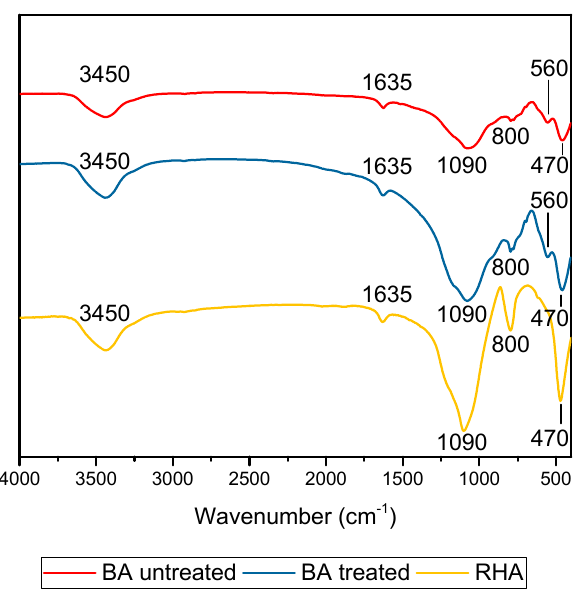
Figure 4. Fourier-transform Infrared (FTIR) spectra for precursor minerals: Bottom ash (BA) untreated, BA treated, after grinding and calcination at 600 ºC (1 h); Rice husk ash (RHA),